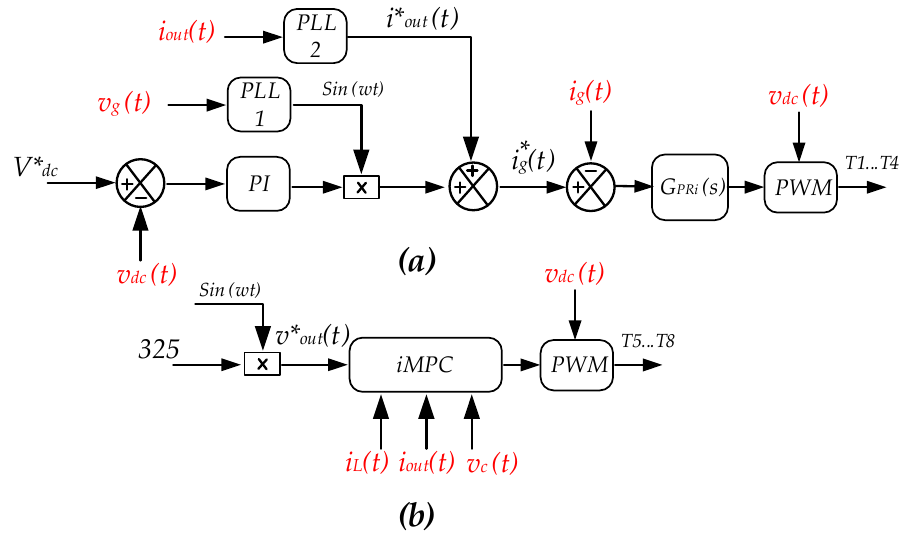
Figure 4. The proposed control system structure of the ER primary grid-side VSI1 control ( a ) and output side grid-forming VSI2 control ( b ).